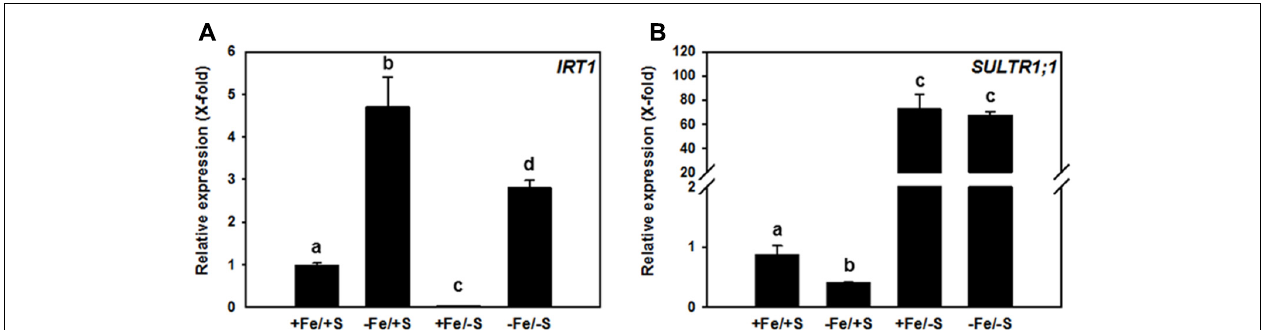
FIGURE 1 | Relative transcript abundance of IRT1 (A) and SULTR1;1 (B) in roots of 7-week-old Arabidopsis thaliana Col-0 plants grown upon different Fe and sulfate supply . Two weeks old plants were transferred to 6 l boxes containing half strength Hoagland medium with combined Fe and S supply ( + Fe = 10 μ M FeHBED Iron [ N , N (cid:2) - di-(2-hydroxybenzyl)-ethylenediamine- N , N (cid:2) -diacetic acid], − Fe = 0.1 μ M FeHBED, + S = 500 μ M MgSO 4 , − S = 1 μ M MgSO 4 ) and grown for 5 weeks under short day conditions (8.5 h day light, 50% relative